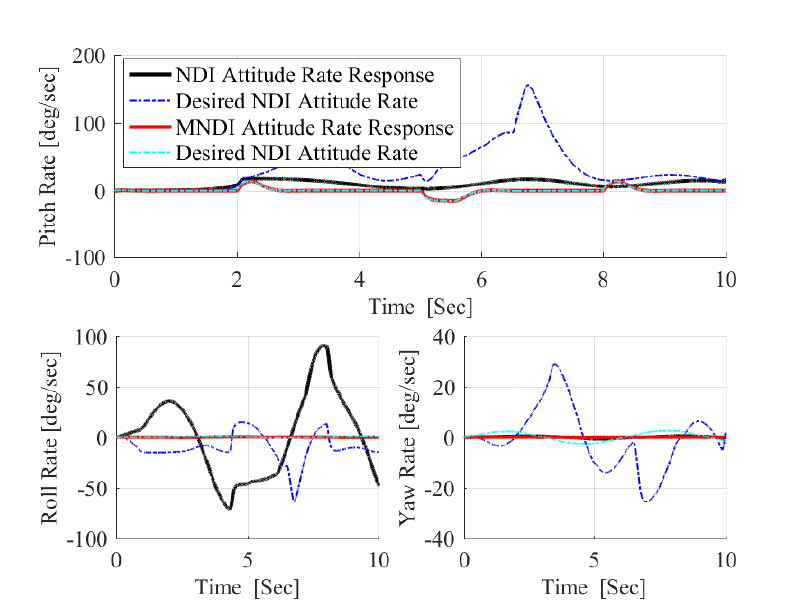
Figure 12. Inner loop rate response for outer pitch angle excitation with wind and uncertainties.